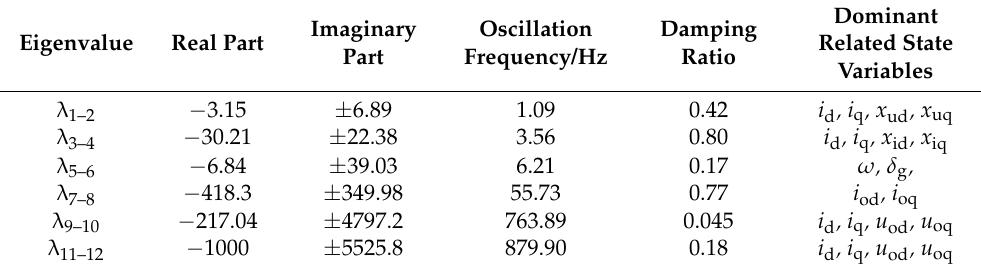
Table 3. Single-VSG system eigenvalues.